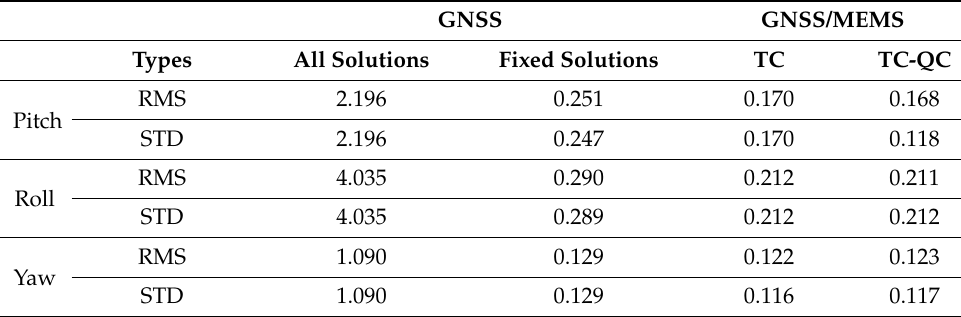
Table 2. Statistics of attitude errors (Unit: degree).